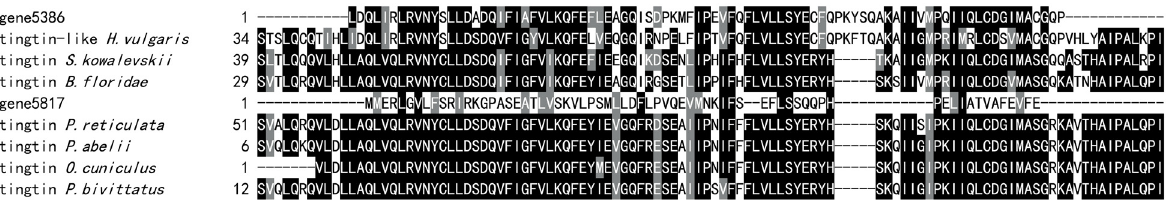
Fig 10. Multiple sequence alignment of the amino acid sequence of unigenes 5396 and 5817 with those of other known huntingtin proteins. The aligned sequences are as follows: Hydra vulgaris huntingtin-like (XP_004206850), Saccoglossus kowalevskii huntingtin (XP_006822985), Poecilia